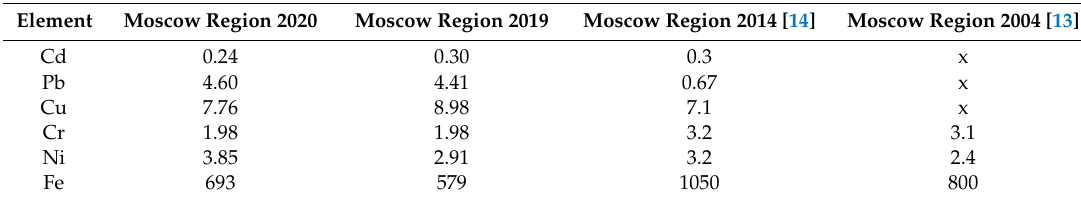
Table 2. Comparison between the median values obtained in the present study and data reported for previous surveys (in mg/kg d.w.).